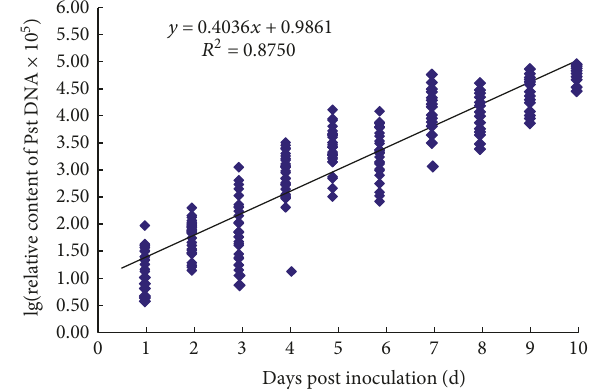
Figure 4: The standard curve of duplex TaqMan real-time PCR for quanti fi cation of wheat DNA and the corresponding linear regression equation.